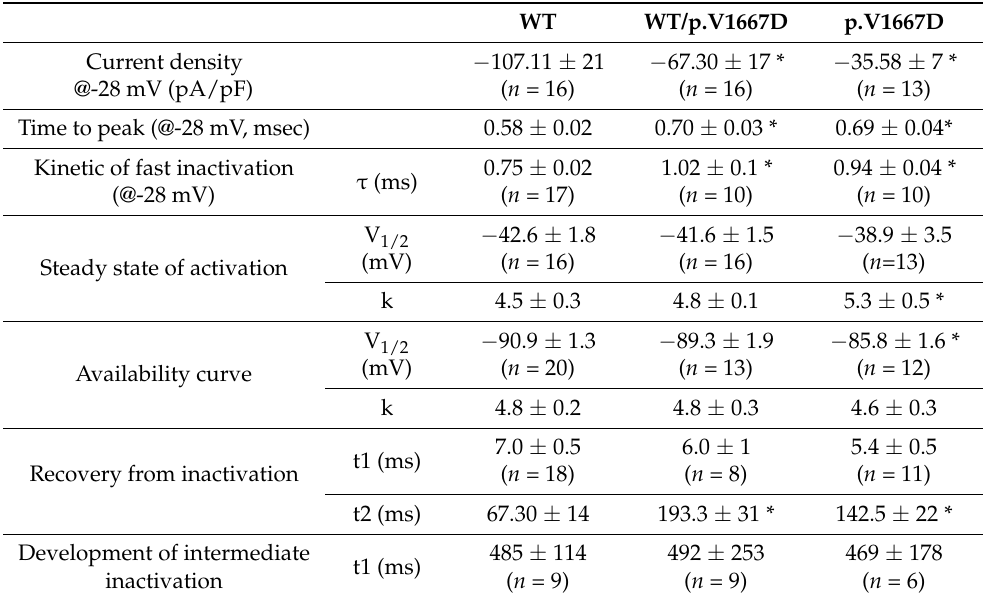
Table 1. Functional characterization of the p.V1667D variant in HEK293 cells and its effect on the wildtype current. (The number in parenthesis represents the cells tested and considered for the analysis; * p < 0.05 vs.